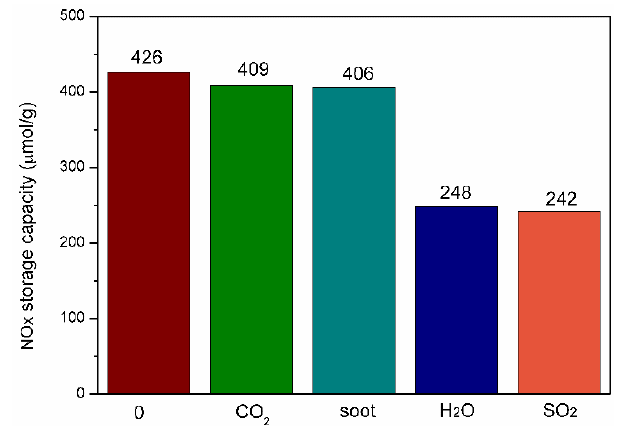
Figure 11. The influence of CO 2 , soot, H 2 O and SO 2 on the NO x storage capacity at 200 °C.